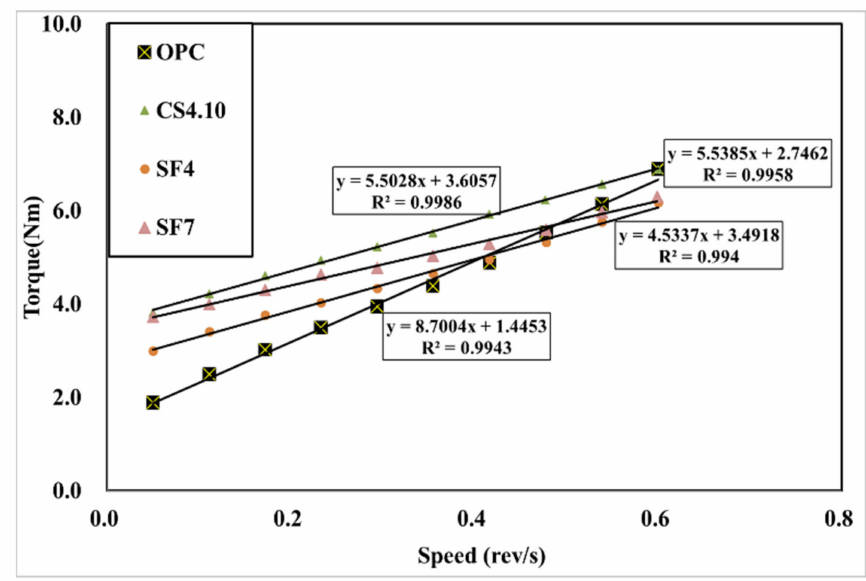
Figure 9. Rheological measurement results according to the mixing ratio of silica fume and colloidal silica.